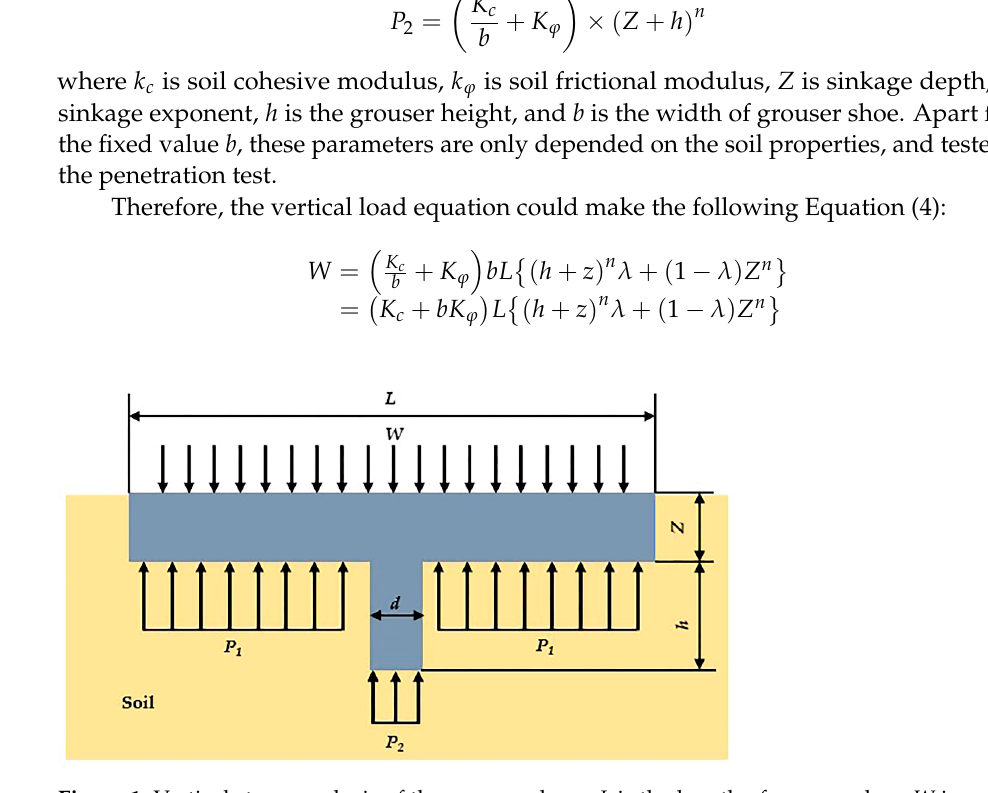
Figure 1. Vertical stress analysis of the grouser shoes. L is the length of grouser shoe, W is vertical